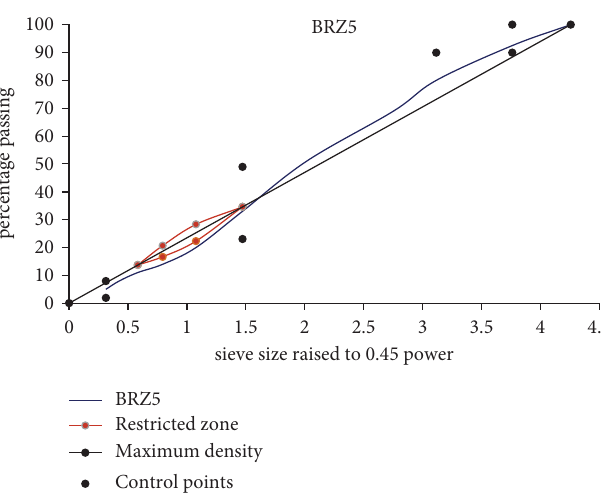
Figure 4: Superpave gradation using 0.45 power chart for 5% CSD